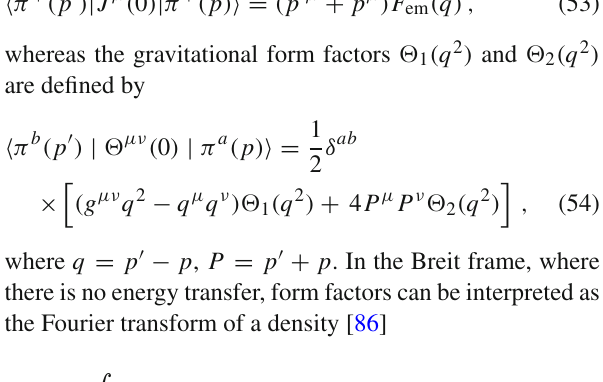
Fig. 3 Renormalized effective range for the integrated-in large- distance wave functions (solid), as a function of the distance for I = 0 (left) and I = 2 (right) It is obtained using the scattering length as input